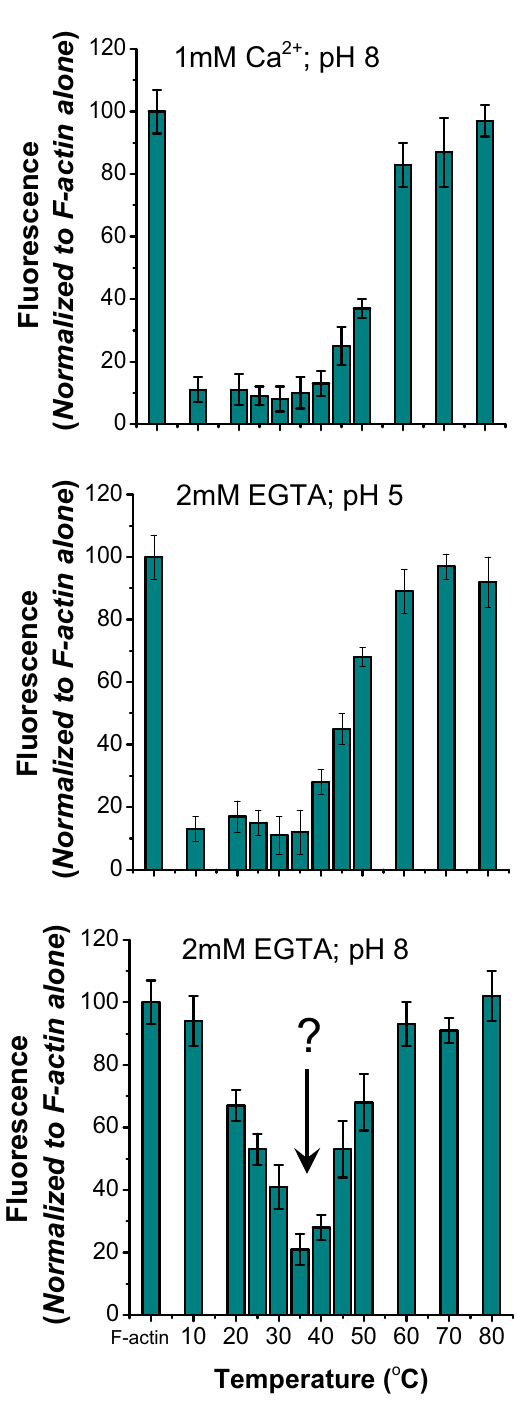
Figure 1. F-actin depolymerizing activities of gelsolin (at 0.83 μ g/ml) are shown here by measuring relative decrement of pyrene fluorescence values as a function of temperature at which gelsolin in different buffers (mentioned in each panel) were heated to before performing the